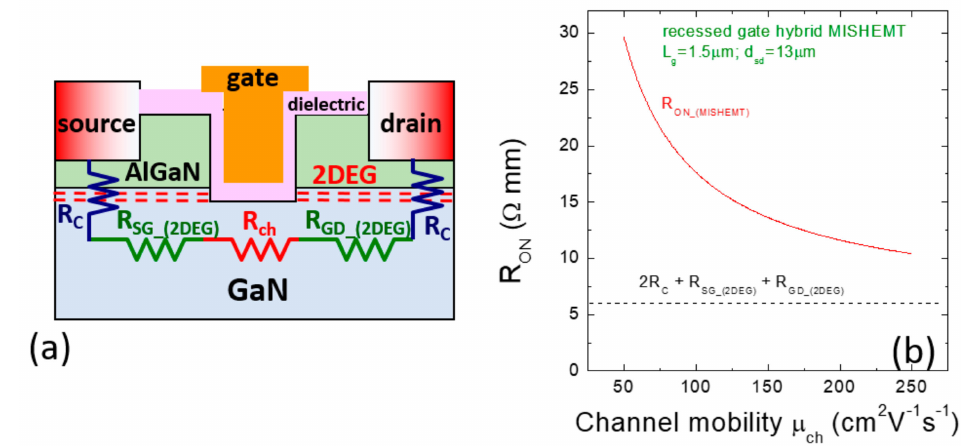
Figure 5. ( a ) Schematic of a recessed gate hybrid MISHEMT. The contributions to the total series resistance are also indicated. ( b ) Total resistance of the MISHEMT R ON_(MISHEMT) as a function of the channel mobility calculated for a device with L g = 1.5 µ m and d sd = 13 µ